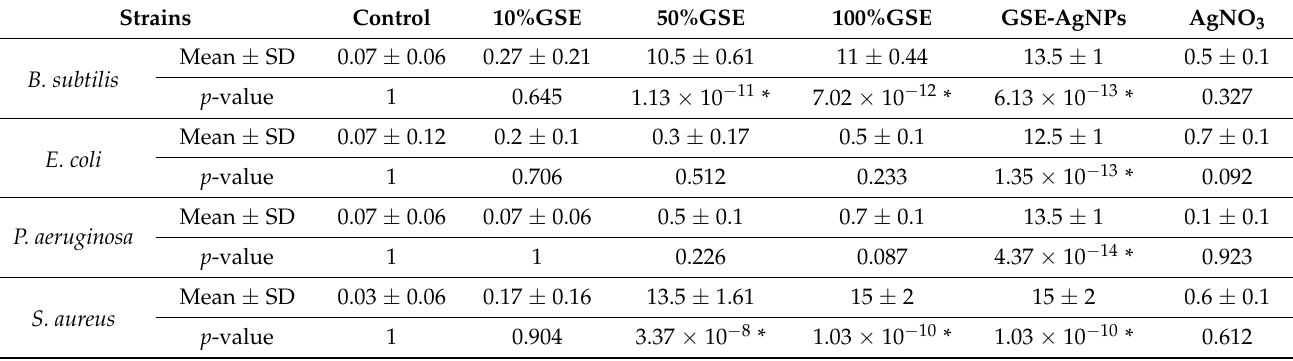
Table 3. The antibacterial effect of GSE and biosynthesized nanoparticles by measuring the inhibition zone diameter (mm). Strains Control 10%GSE 50%GSE